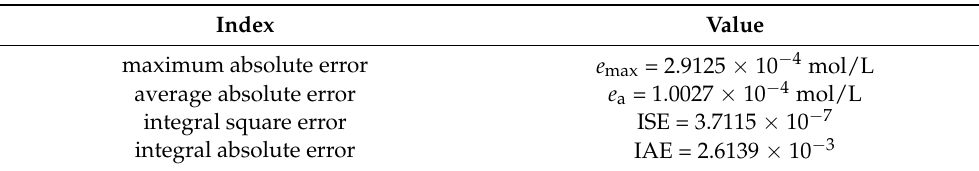
Table 5. Quantitative assessment of the accuracy of the identified model (deviation between simulated and measured